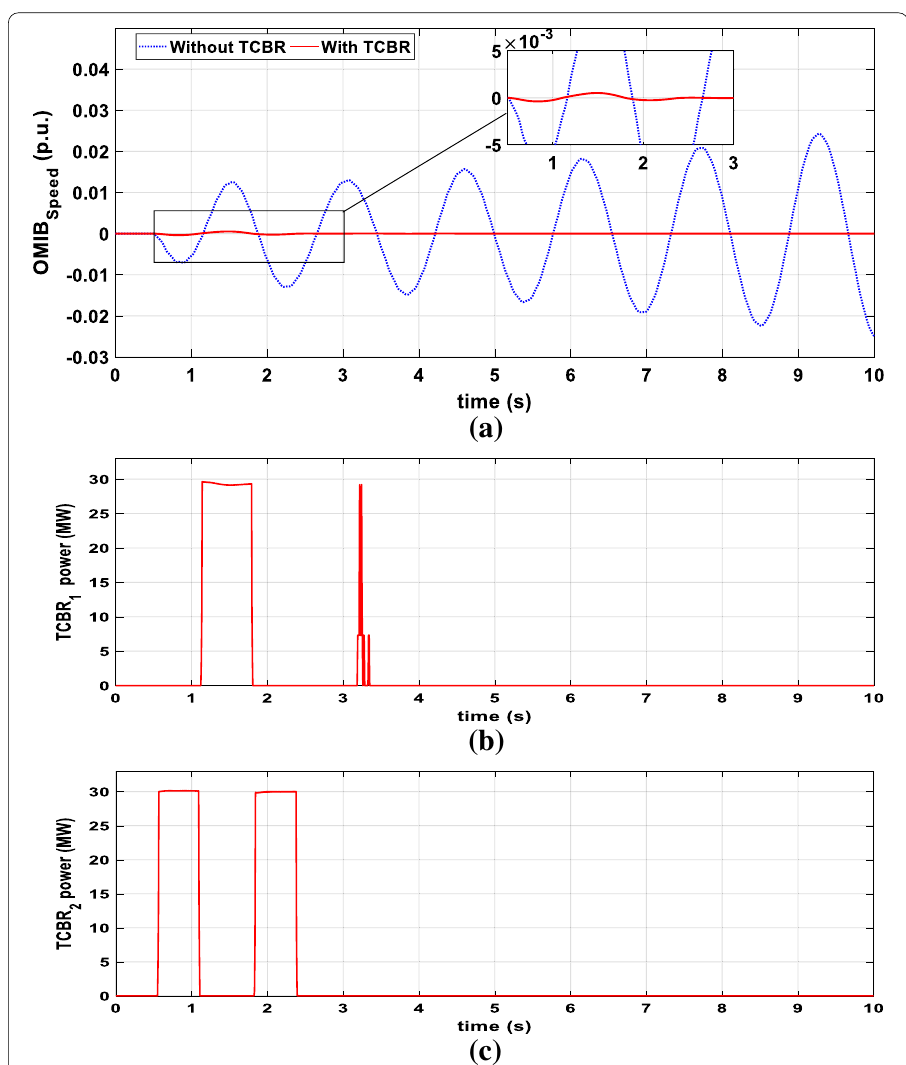
Fig. 7 Case (1) OMIB Speed and TCBR dissipated power responses, a OMIB Speed , b TCBR 1 dissipated power, c